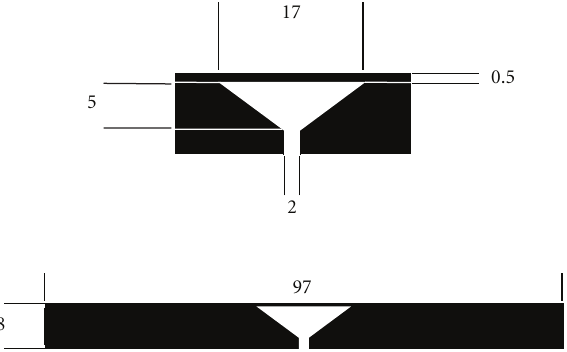
Figure 1: The geometry of the screen-printed tags. Dimensions are in